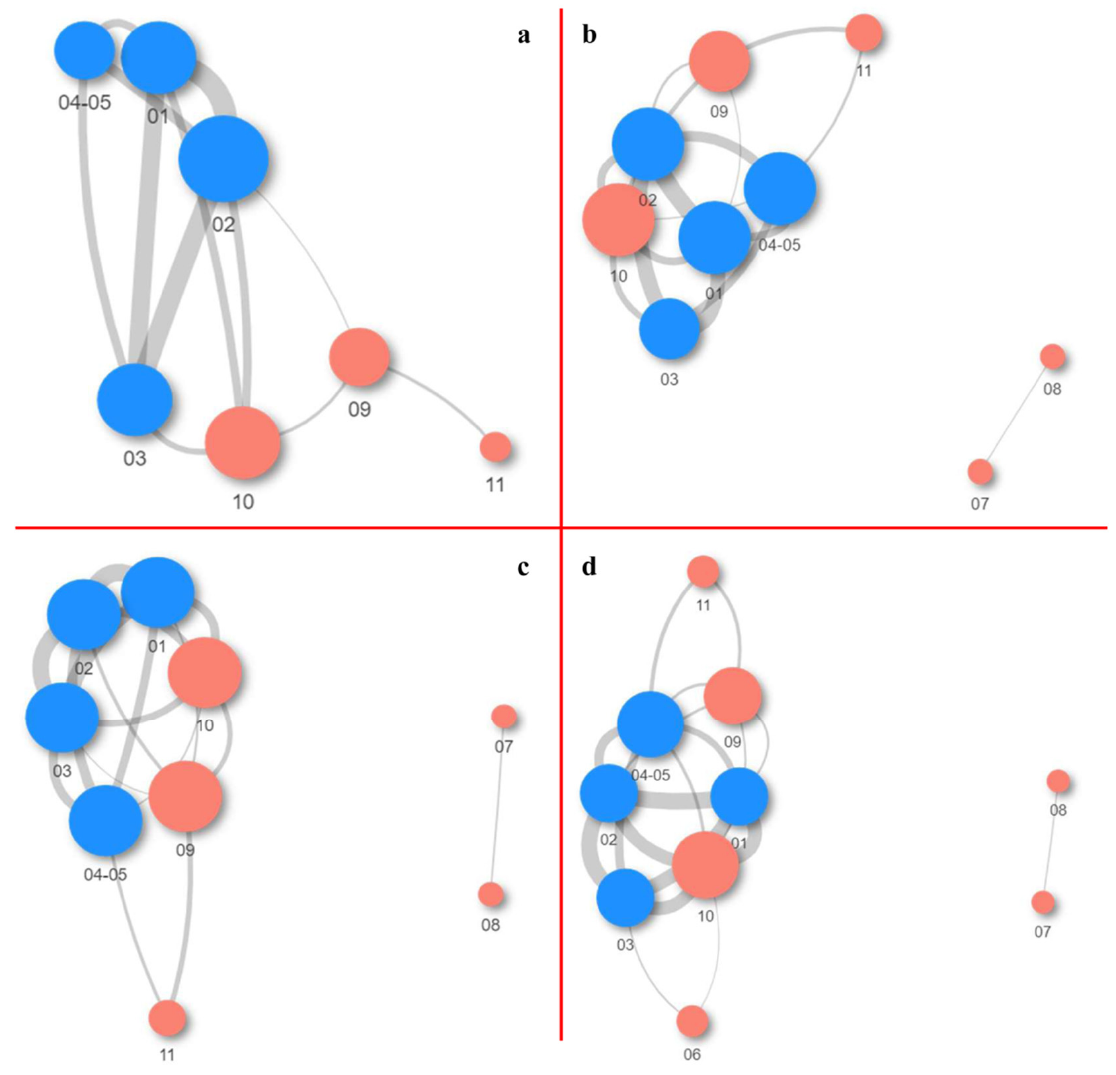
Figure 2. Network analysis of samples with Weighted UniFrac distances at the: ( a ) ASV; ( b ) genus; ( c ) family; and ( d ) phylum taxa levels. Node size corresponds to the number of connections, while edge width corresponds to the distance among samples (closer distances equal wider edges). Red nodes are from the samples around the fresco, while blue nodes are the fresco’s samples.